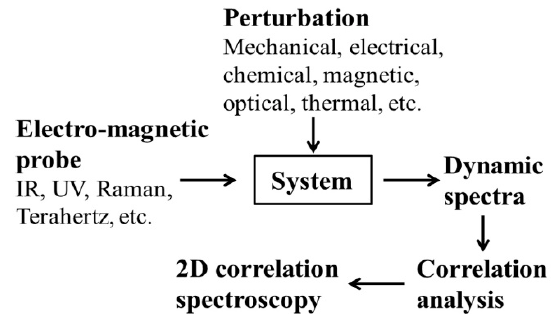
Figure 2. Schematic illustration of the flow chart for obtaining the 2D correlation spectra.